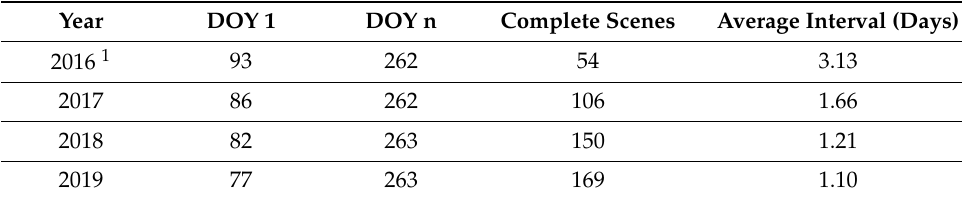
Table 2. S-2 data coverage by year, with day of the year (DOY) 1 as the day of the first complete set for the respective year and DOY n as the last day with a complete scene set.